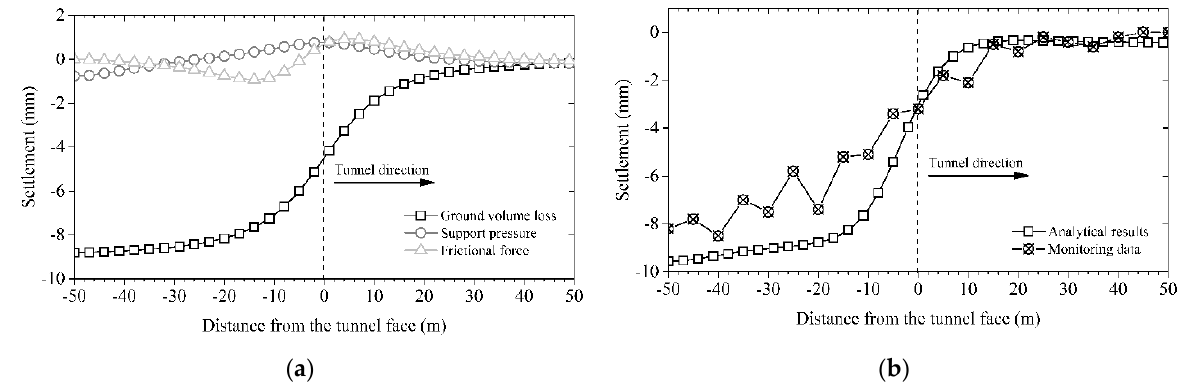
Figure 10. Longitudinal profiles of pipeline deformation during shield tunnelling: ( a ) ground deformation at pipeline’s elevation; ( b ) analytical results and monitoring data.